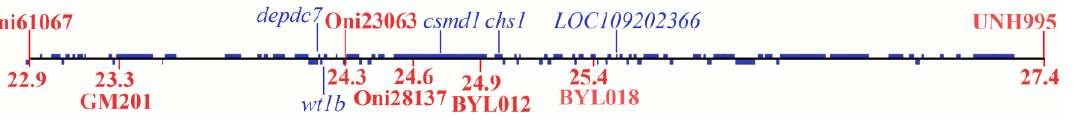
Figure 1. Genetic markers (red) and genes (blue) previously linked with sex on LG1. Positions (Mbp) of genes and genetic makers on the current On genomic map build (Genome accession number: GCA_001858045.3) are denoted. Gene symbols of genes mentioned in this article are indicated below or above the bars that delineate their positions.